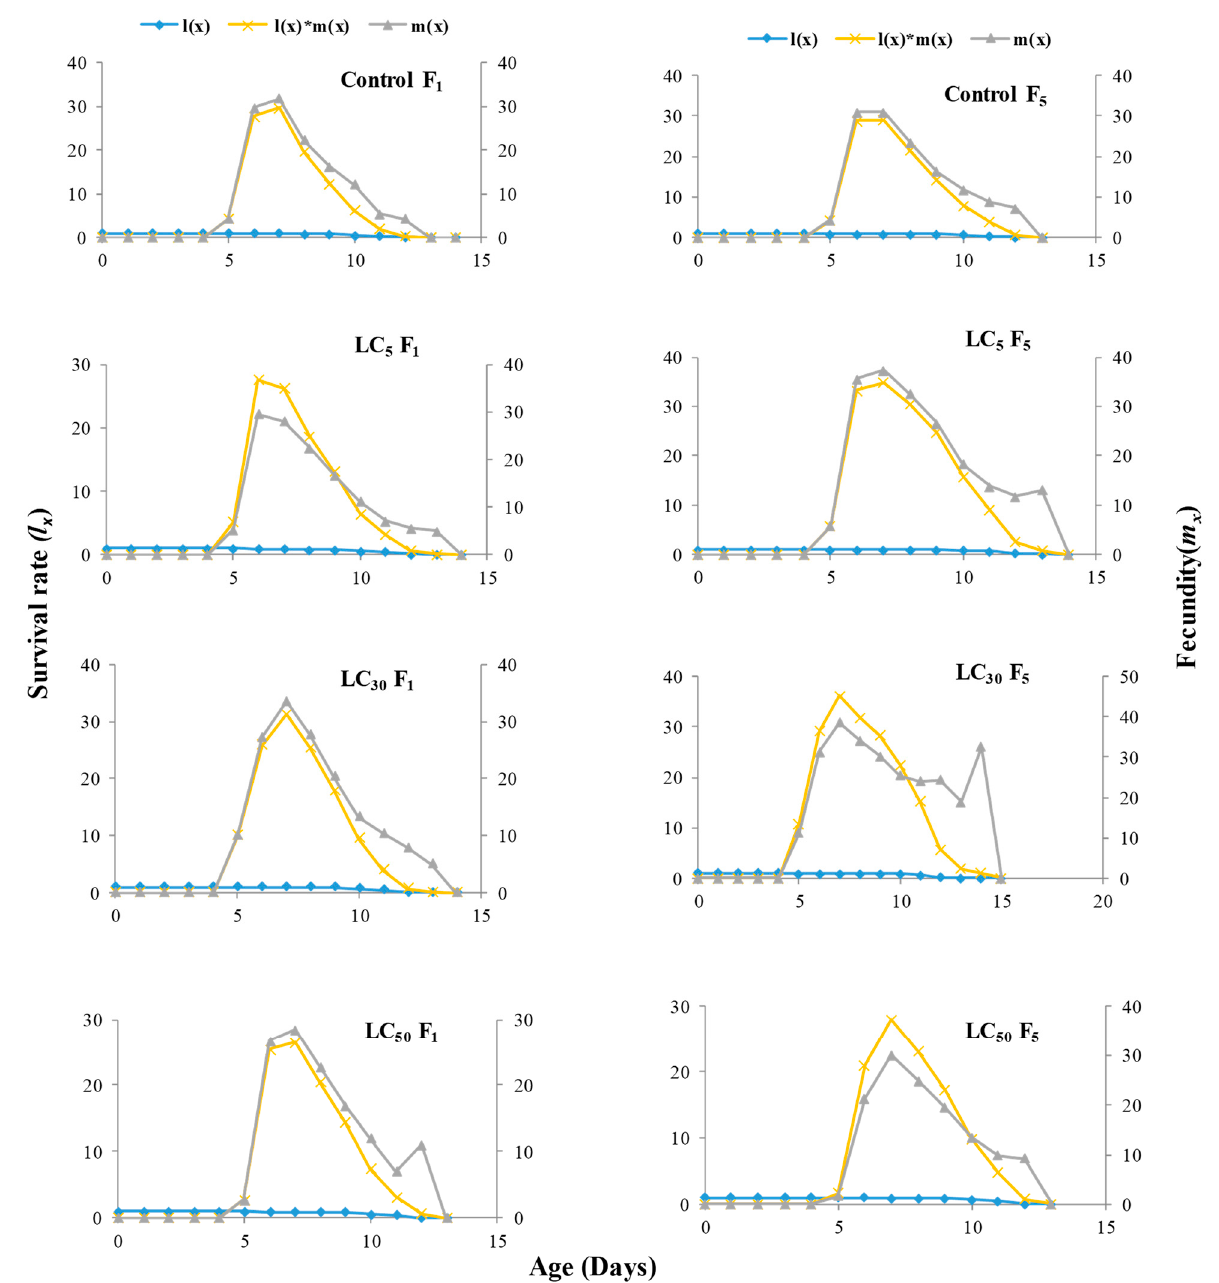
Figure 2. Age–specific survival rate ( l x ), age–specific fecundity of total population ( m x ), and age– specific maternity ( l x m x ) of T . chilonis adults of imidacloprid in F 1 and F 5 generations.